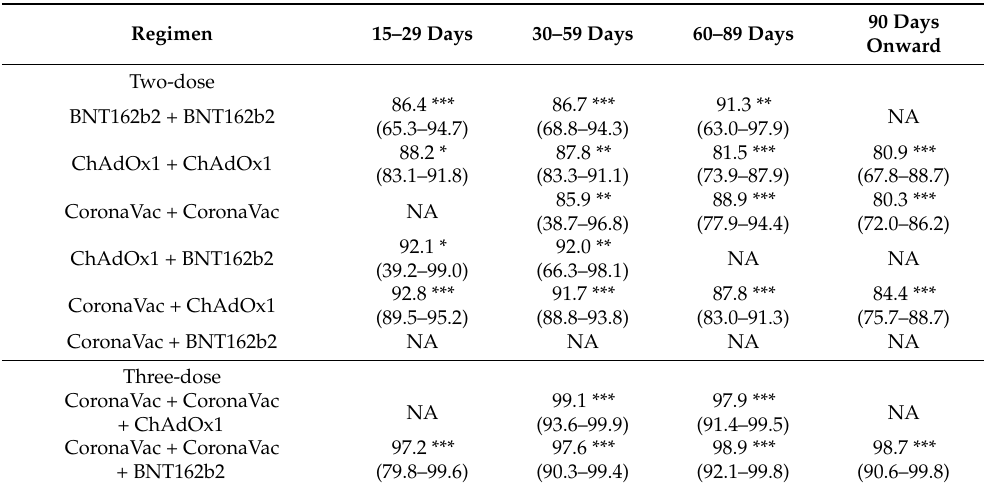
Table 4. Vaccine effectiveness against severe infection for two-dose and three-dose vaccine regimens sorted by time since last